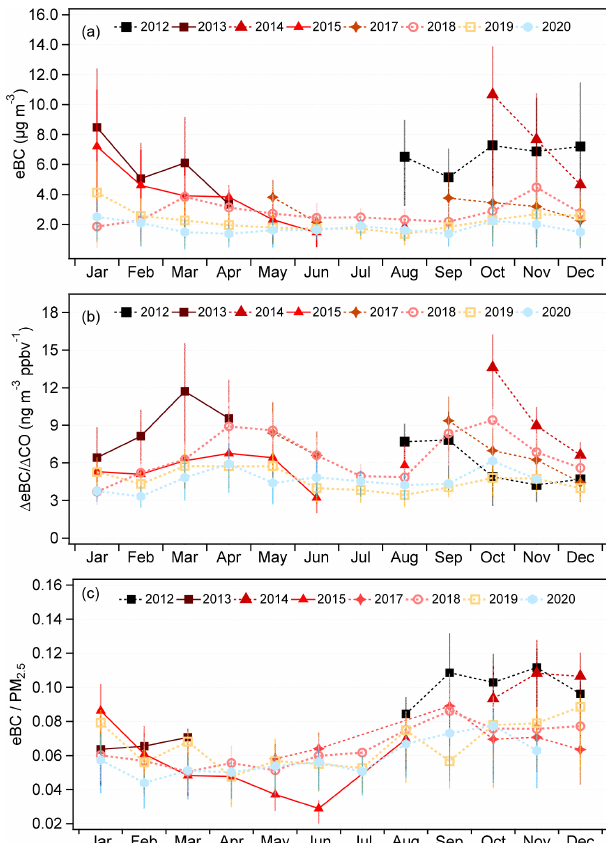
Figure 2. Monthly variations in (a) eBC, (b) (cid:49) eBC /(cid:49) CO, and (c) eBC / PM 2 . 5 . The mean (markers) and 25th and 75th percentiles (sticks) are also